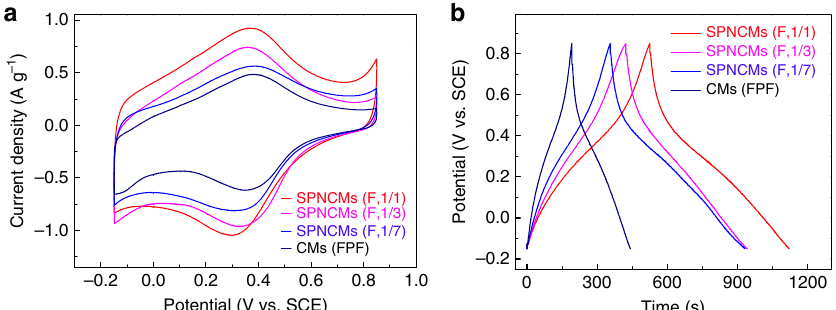
Fig. 5 Electrochemical evaluation. a CV test and b GCD curves obtained with a three-electrode system at a scan rate of 1 mV s − 1 and a current density of 1 A g − 1 in 1.0 M H 2 SO 4 electrolyte for the SPNCMs (F, 1/1), SPNCMs (F, 1/3), SPNCMs (F, 1/7), and CMs (FPF) used as work